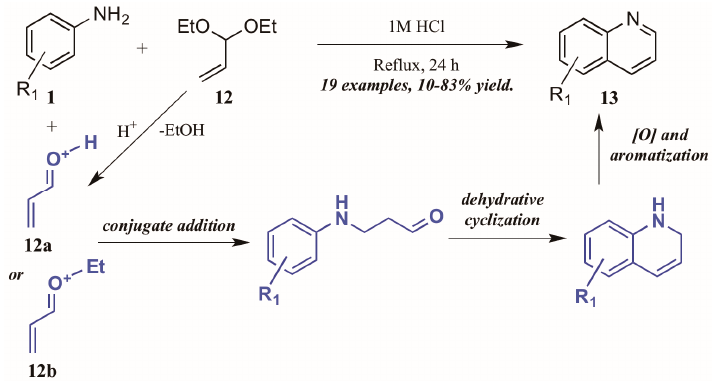
Figure 9. Doebner–Von Miller cyclization of anilines with acrolein diethyl